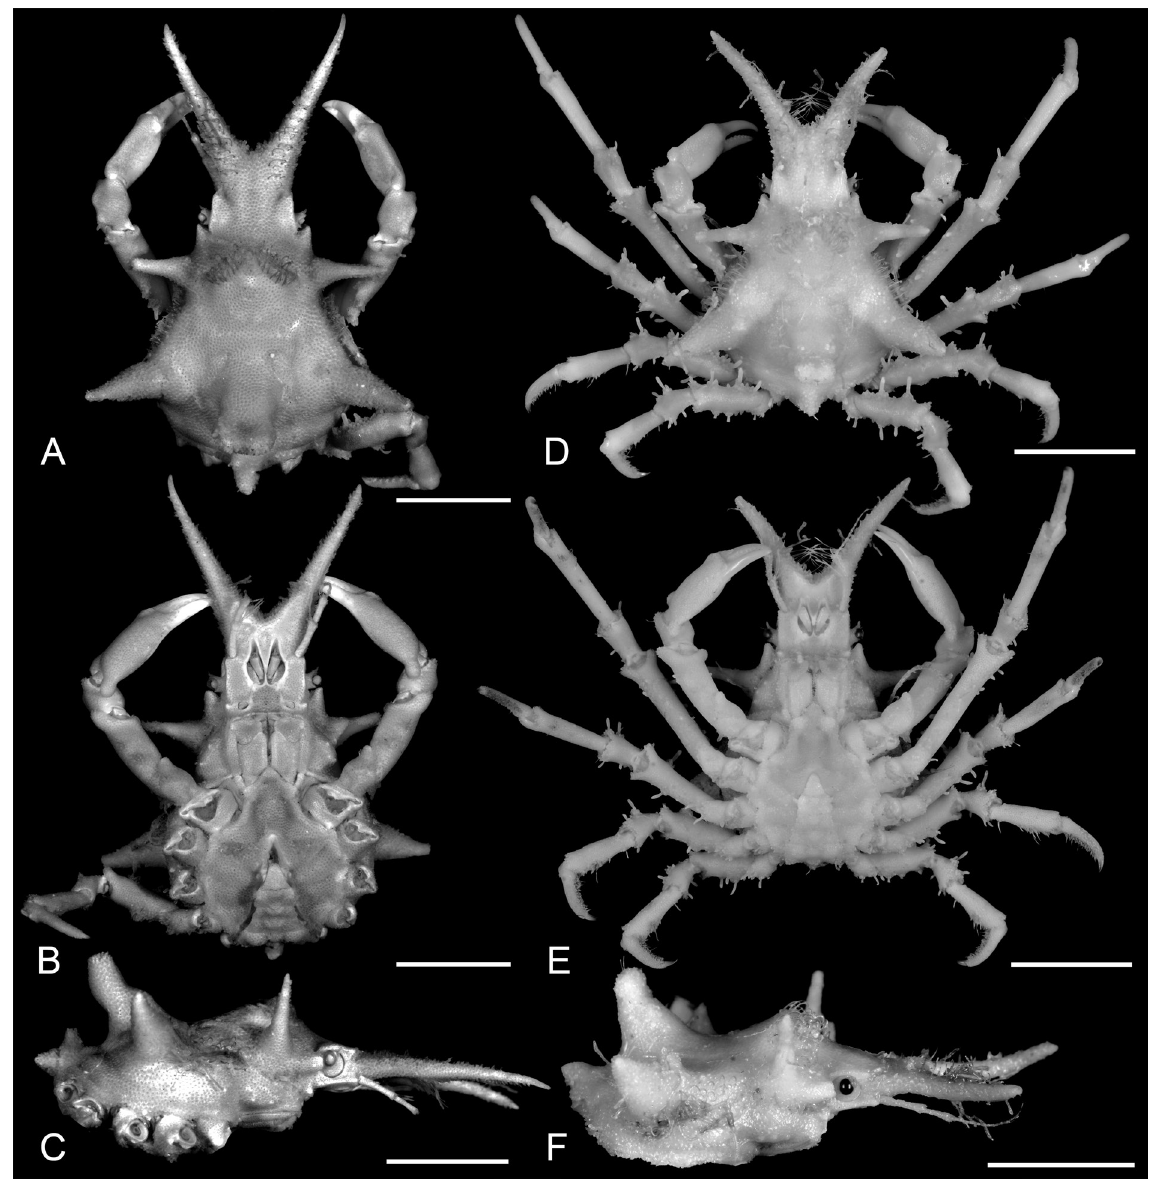
Fig. 10. A–C . Rochinia kagoshimensis (Rathbun, 1932), holotype, ♂ (11.2 × 6.8 mm) (USNM 48253), off Kagoshima gulf. A . Overall dorsal view. B . Overall ventral view. C . Lateral view of carapace. D–F . Rochinia kagoshimensis (Rathbun 1932) comb. nov., ♂ (10.7 × 6.9 mm) (ZRC 2016.0549),